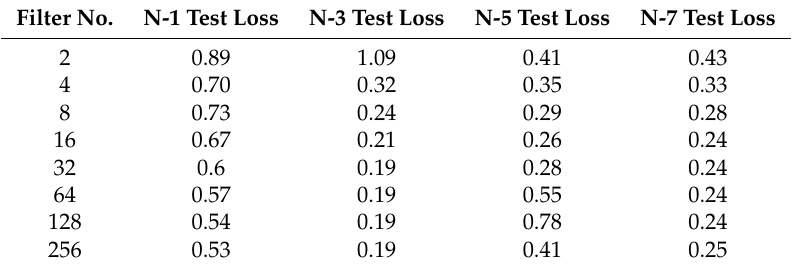
Table 3. Loss Rate of model networks using various number of learnable filters on N-3, N-5 and N-7